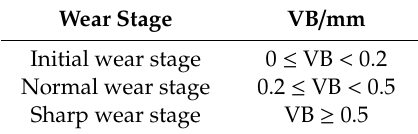
Table 4. Division of the tool wear stages. VB: maximum width of the wear land.